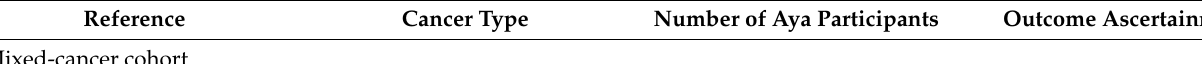
Adjusting for neoplasia and sex: Higher risk of dying for individuals with non-hematological neoplasia (solid tumors) compared with individuals diagnosed with leukemias and lymphomas (HR: 1.47, 95% CI: 1.12–1.93). Compared with individuals diagnosed with leukemias on mortality) and lymphomas, individuals diagnosed with non-hematological neoplasia had greater risk of